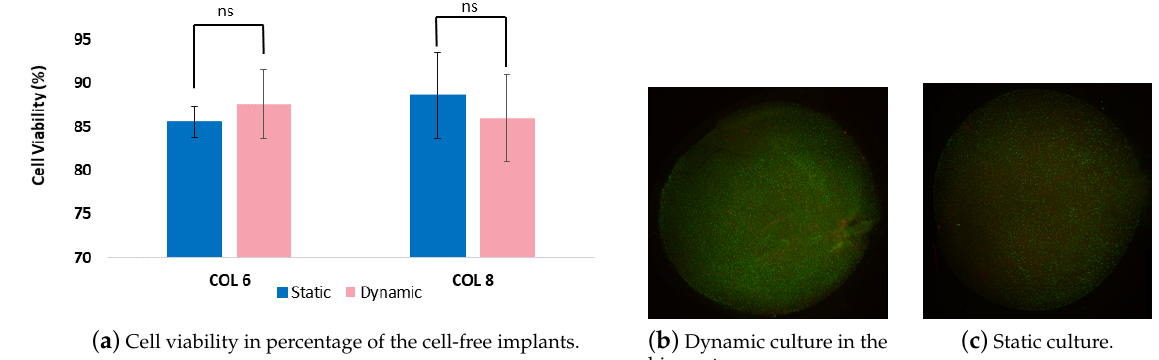
Figure 9. ( a ). The graph shows cell viability percentages of cells which migrated from the cell-seeded collagen scaffolds into cell-free collagen-I-based implants. ( b , c ). Randomly chosen pictures taken from the chondrocyte-seeded collagen matrix were cultured dynamically ( b ) and statically ( c